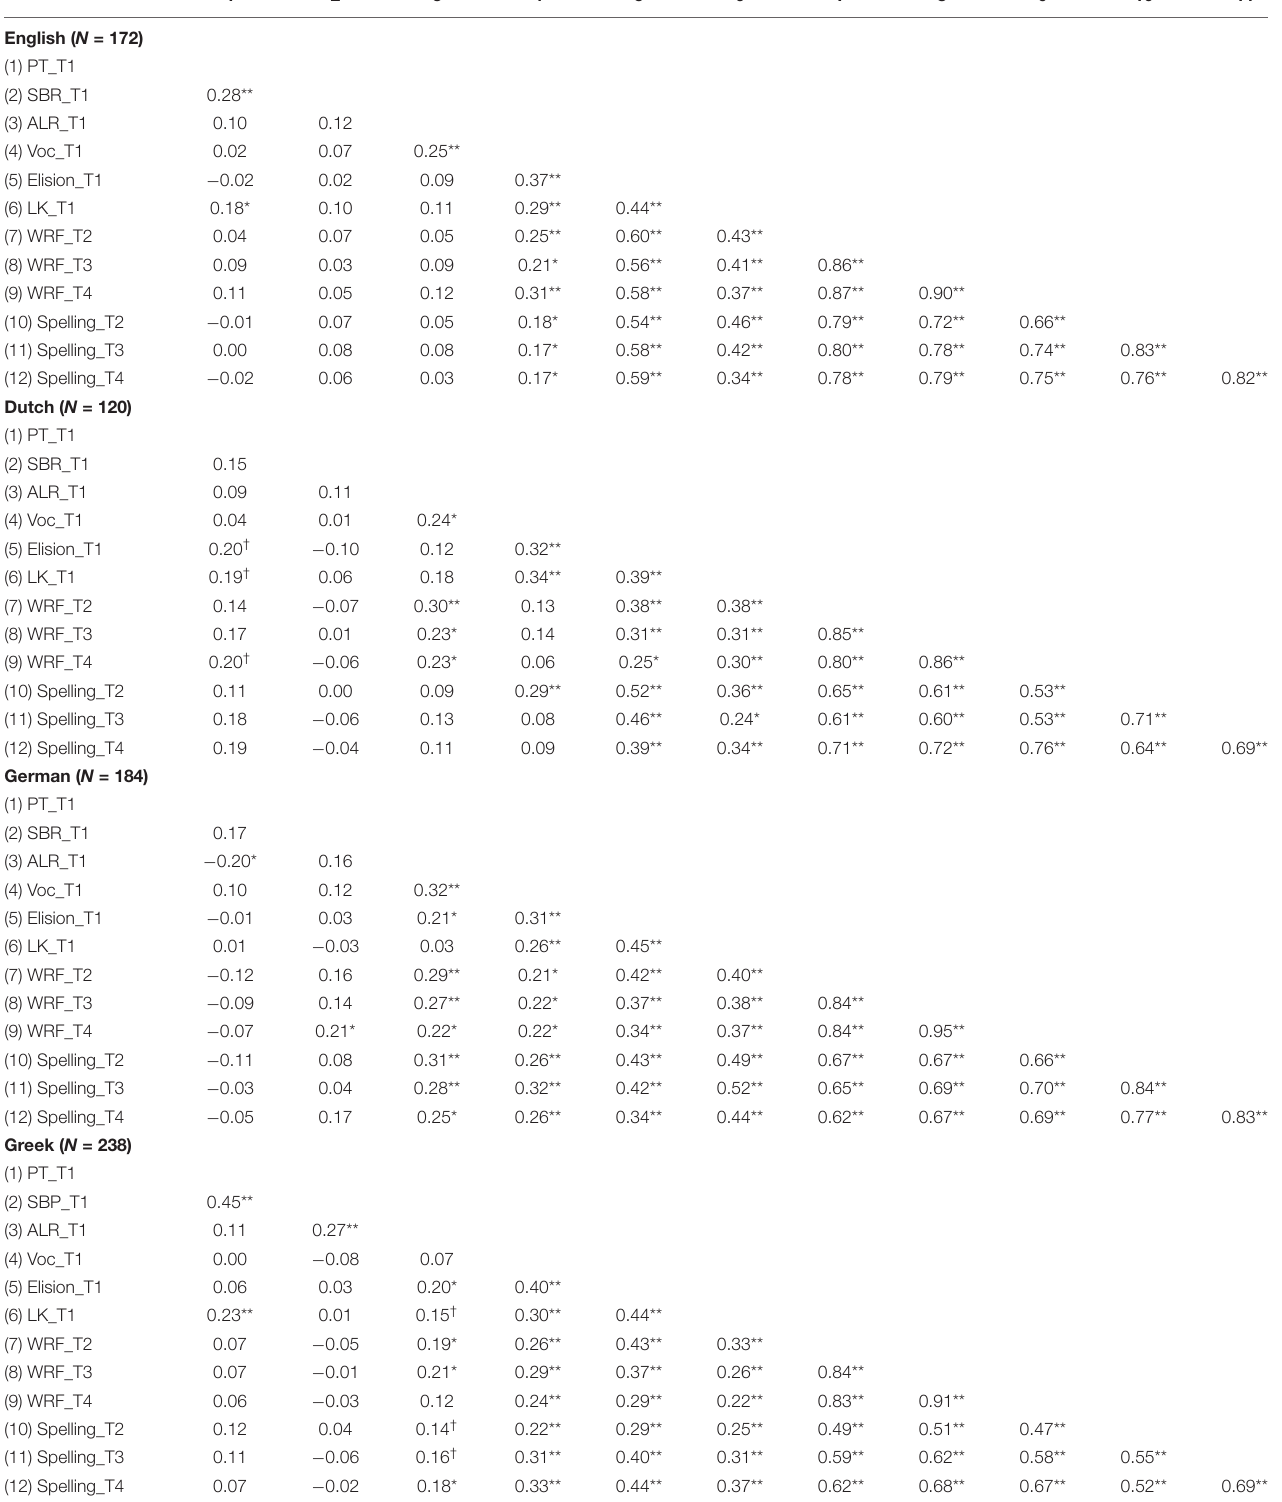
TABLE 4 | Correlations among the observed variables for each